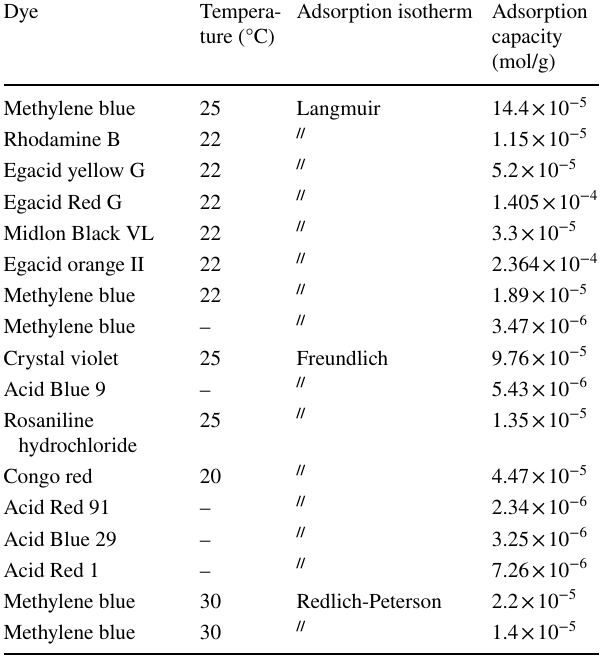
Table 3 Adsorption of dyes on CFA (Wang and Wu 2006)